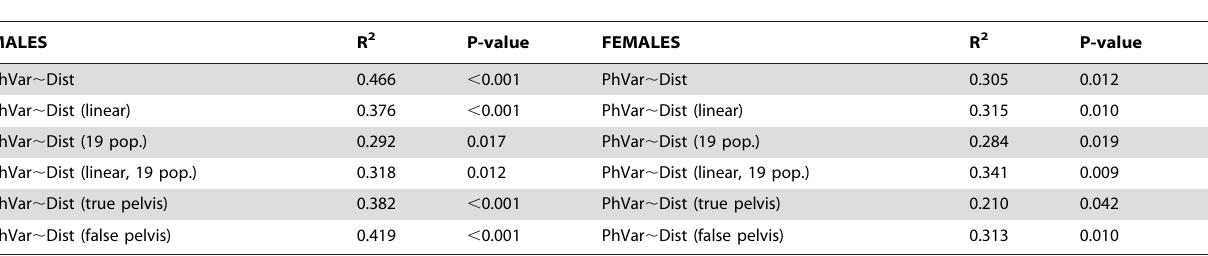
Table 5. Results of linear regression